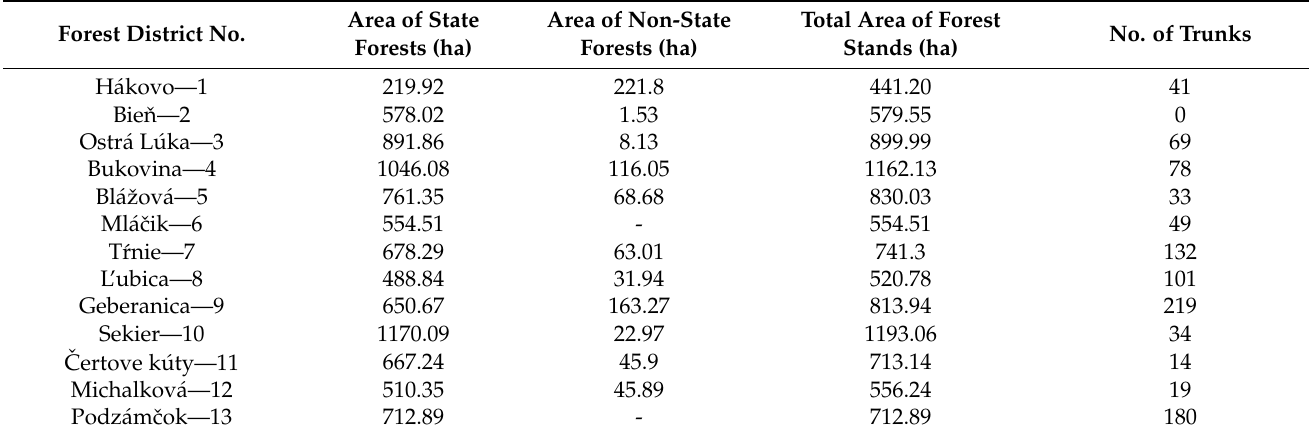
Table 1. Organizational structure of the University Forest Enterprise, forest districts, corresponding area of forest stands, and their numbering at the time of analyzing the qualitative